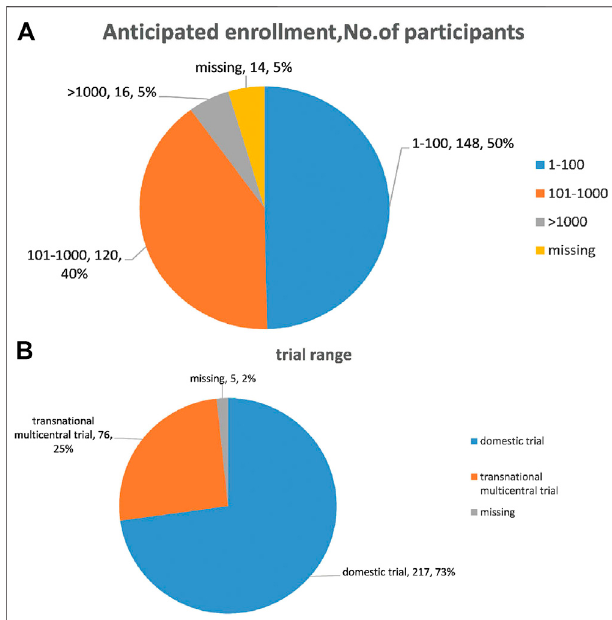
FIGURE 3 | Analysis of clinical trial characteristics of suspended trials. (A) Drug type analysis of suspended trials; (B) indication fi elds analysis of suspended trials; (C) range analysis of suspended trials; (D) phase analysis of suspended trials; (E) age analysis of subjects in suspended trials;